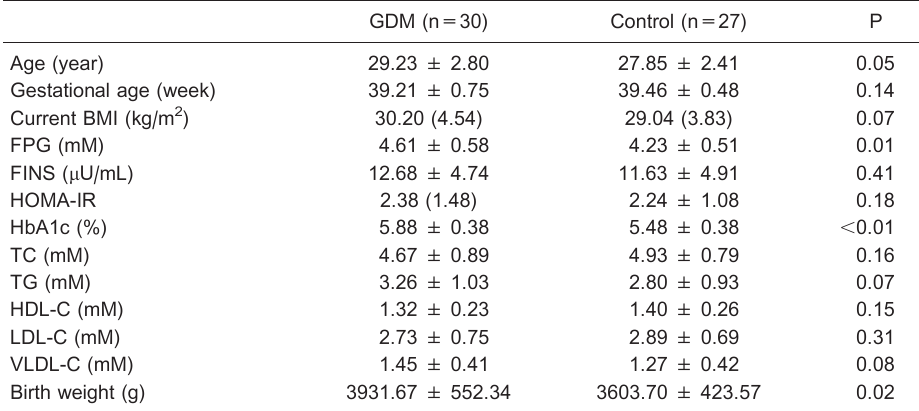
Table 2. Clinical and demographic characteristics of the gestational diabetes mellitus (GDM) and normal glucose tolerance (control) groups.